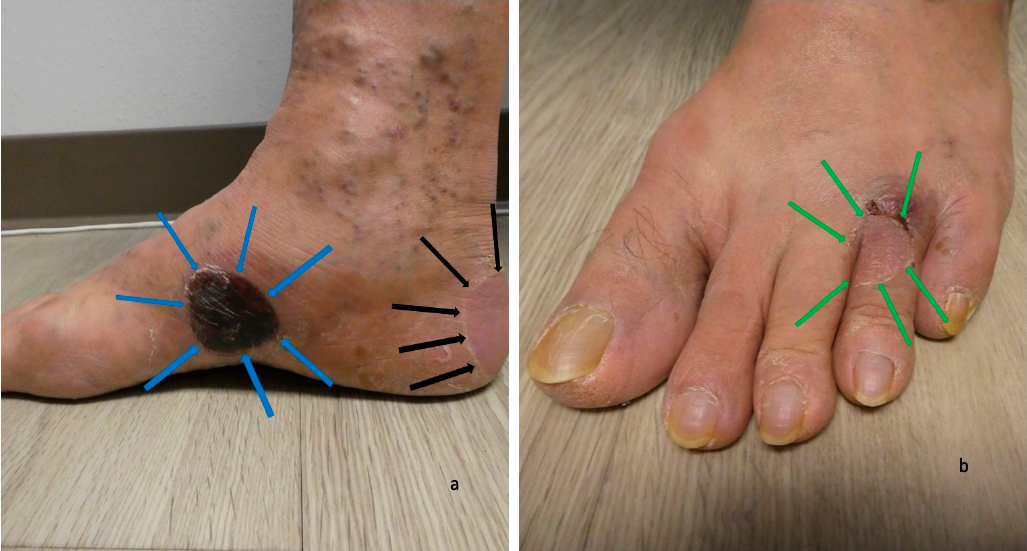
Figure 2. Blisters of dyshidrosiform bullous pemphigoid on the feet. A black-roofed and flattened blister on the instep (outlined in blue arrows) and another flattened blister that is primarily on the posterior heel and extends to the plantar foot (outlined in black arrows) on the medial foot ( a ) of a 61-year-old man. A deroofed blister is on the proximal fourth toe (outlined in green arrows) of the left dorsal foot ( b ). The figure and legend were originally published in Cureus under the Creative Commons (CC-BY): https://creativecommons.org/licenses/ on 11 January 2020 (Cohen PR: Dyshidrosiform bullous pemphigoid: Case reports and review. Cureus. 2020 Jan 11:12(1):e6630) and are republished with permission.